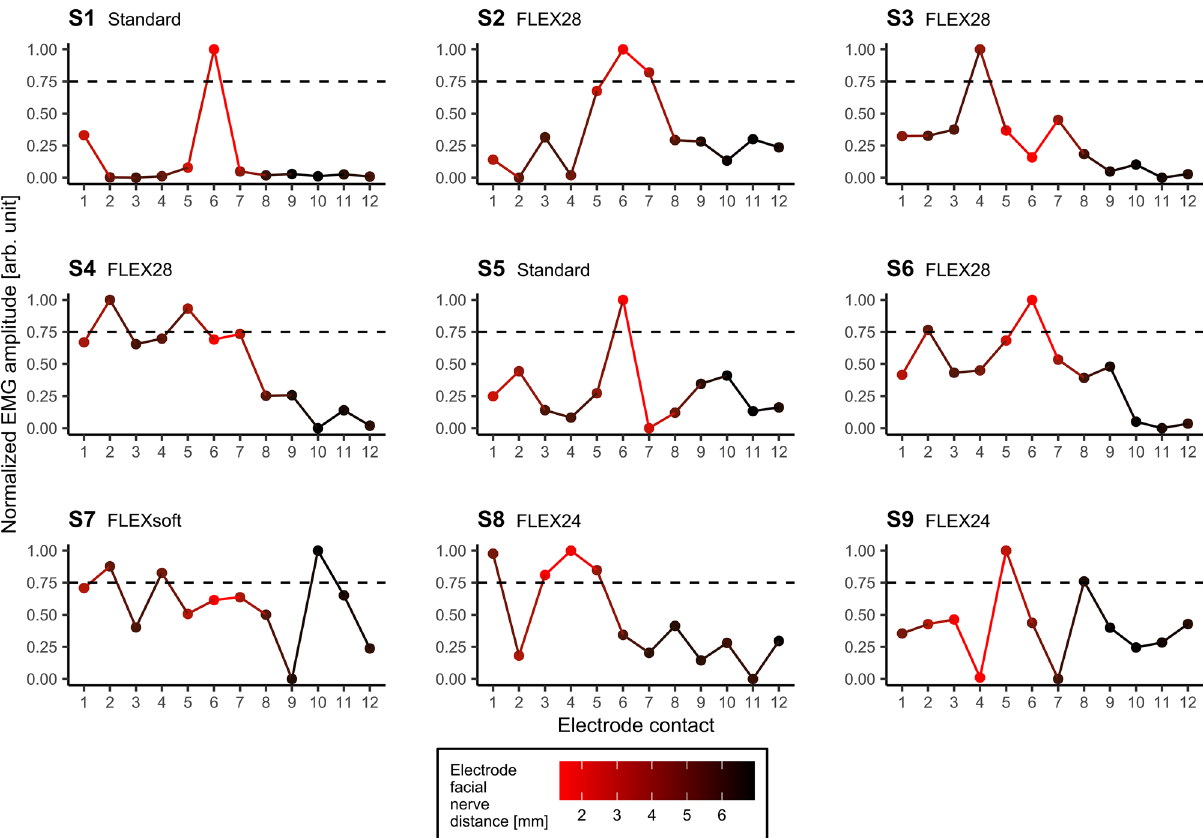
Figure 7. Normalized EMG responses of the M. orbicularis oculi as function of the contacts on the fully inserted electrode array. The color gradient depicts the radiologically determined electrode facial nerve distance (red: shortest distance; black: longest distance) for each subject. The horizontal dashed line indicates the arbitrarily chosen EMG threshold at 75% normalized EMG